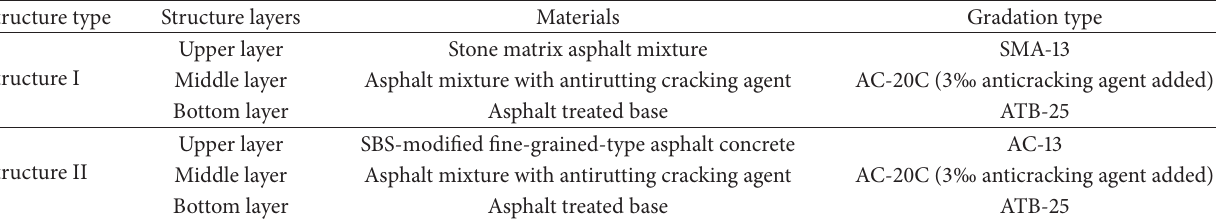
Table 6: Two typical structures of asphalt pavements in a flat slope section of an